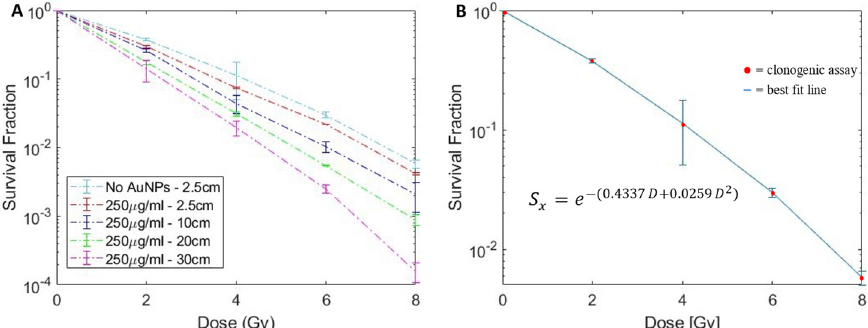
Figure 5. ( A ) Survival fraction curve of LNCaP cells treated with 250 µg/mL PSMA-AuNPs irradiated in vitro at various depths in water. ( B ) Survival fraction curve fitting of LNCaP cells without AuNPs for LQM α and β values. Table 1. LQM α and β values extracted by curve fitting the clonogenic assay derived survival fractions at each depth for AuNP treated and untreated LNCaP cells in vitro . Values are presented with 95% confidence intervals.